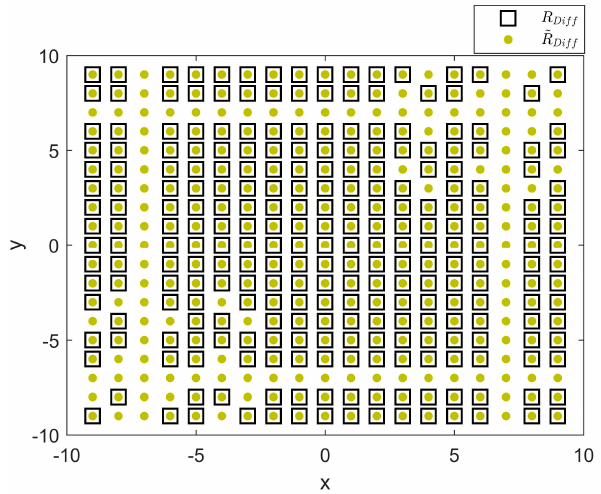
R and  R when ,   3 4 M M . Diff Diff 1 2